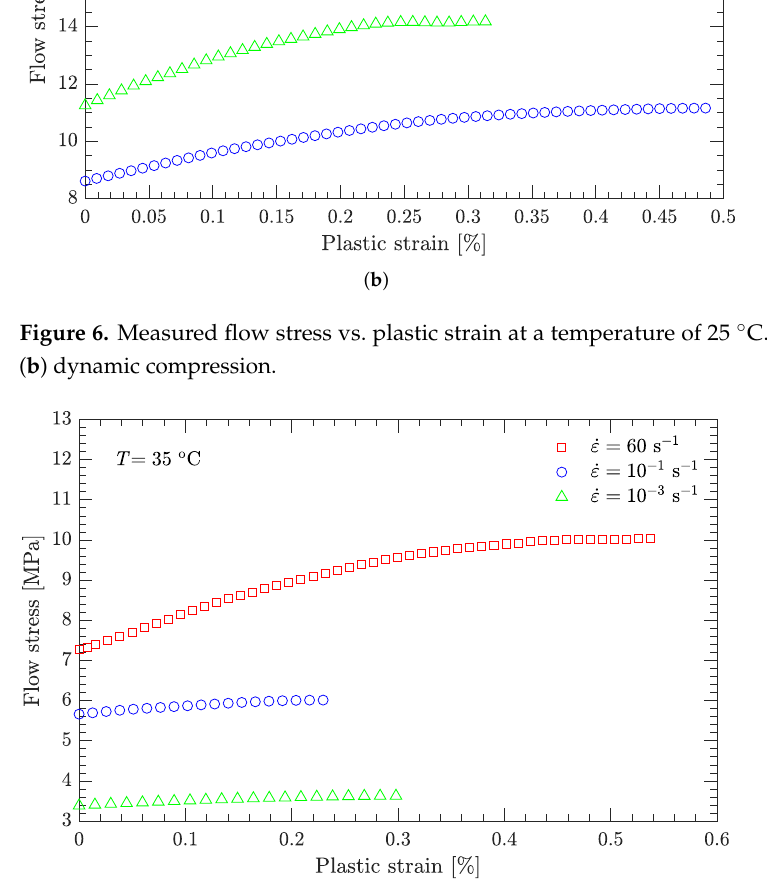
Figure 7. Measured flow stress vs. plastic strain at a temperature of 35 ◦ C.